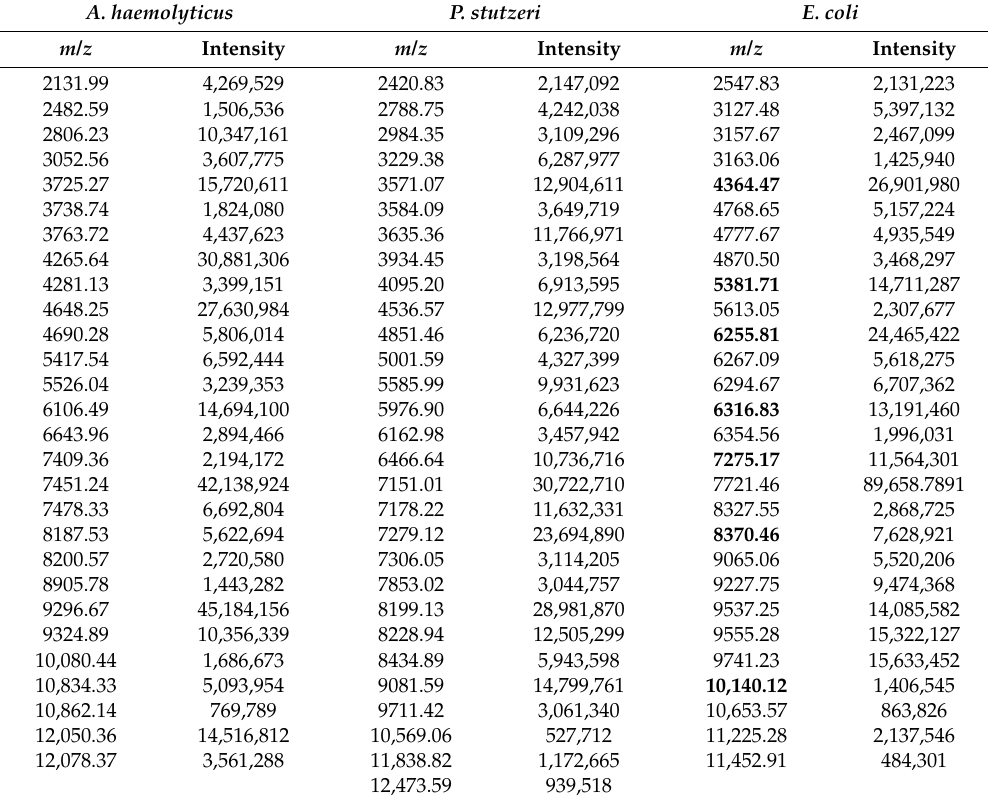
Table 3. Masses derived from A. haeomlyticus , P. stutzeri , and E. coli DH5 α preparations and their respective